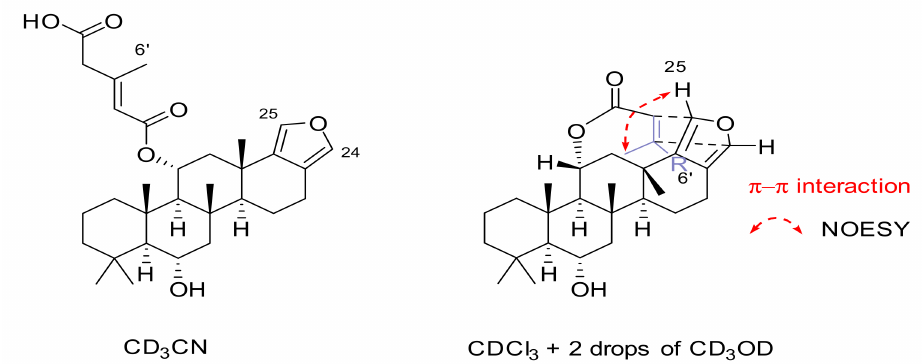
Figure 5. Effect of the NMR solvent on the conformation of compound 4